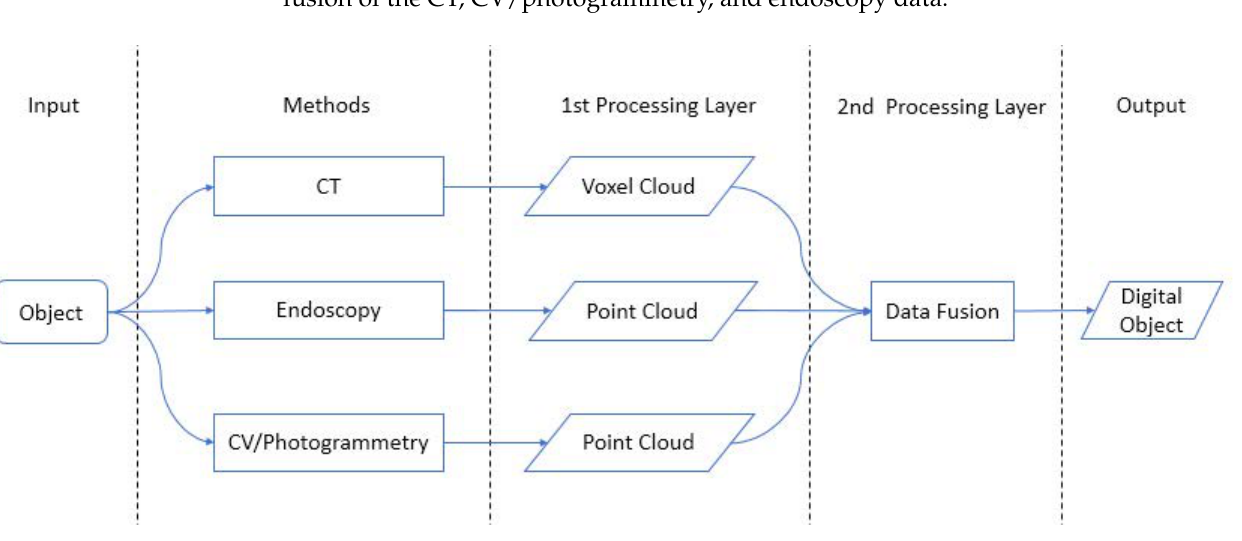
Figure 3. Processing pipeline of the Gyrolog